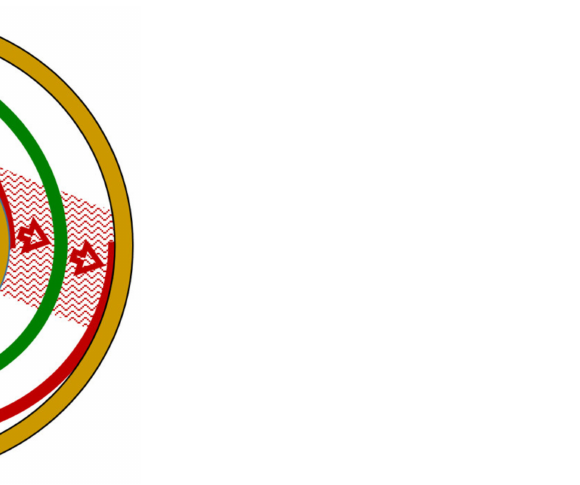
Figure 2. Top view on the model of perfectly anti-symmetric halo current component having a pair of identical helical bridges (red and green arrows) spaced in toroidal direction by 180 degrees and carrying always equal by modulus but opposite currents. Yellow rings schematically represent cross sections of VV walls, inboard and